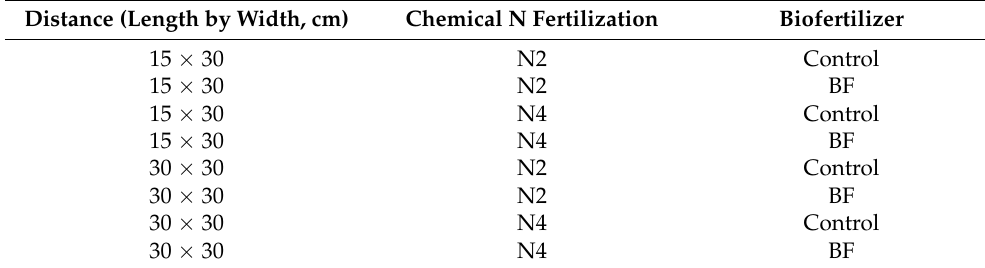
Table 1. The field design of the